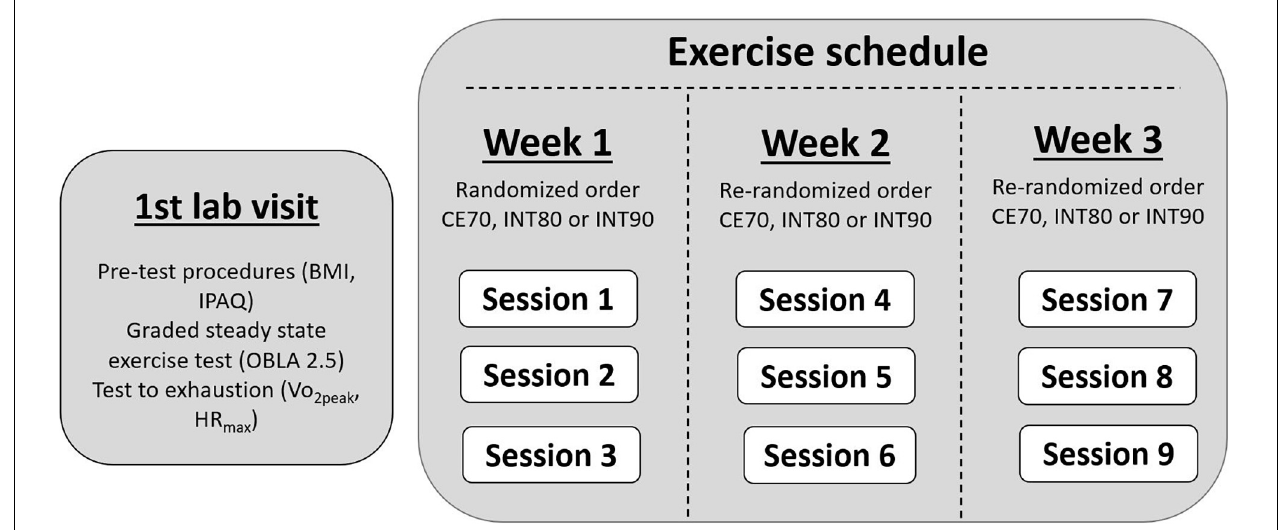
FIGURE 1 | Baseline testing and three-week exercise schedule. BMI, Body Mass Index; IPAQ, International Physical Activity Questionnaire; OBLA 2.5, Onset of blood lactate accumulation at 2.5 mmol/L; VO 2 peak , Peak Oxygen Uptake; HR max , maximal heart rate; CE70, moderate intensity continuous exercise at 70% of